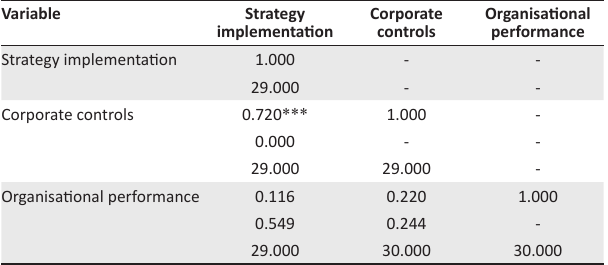
Note: *** , significant at the 1 % level. TABLE 3a: Strategy implementation. Source